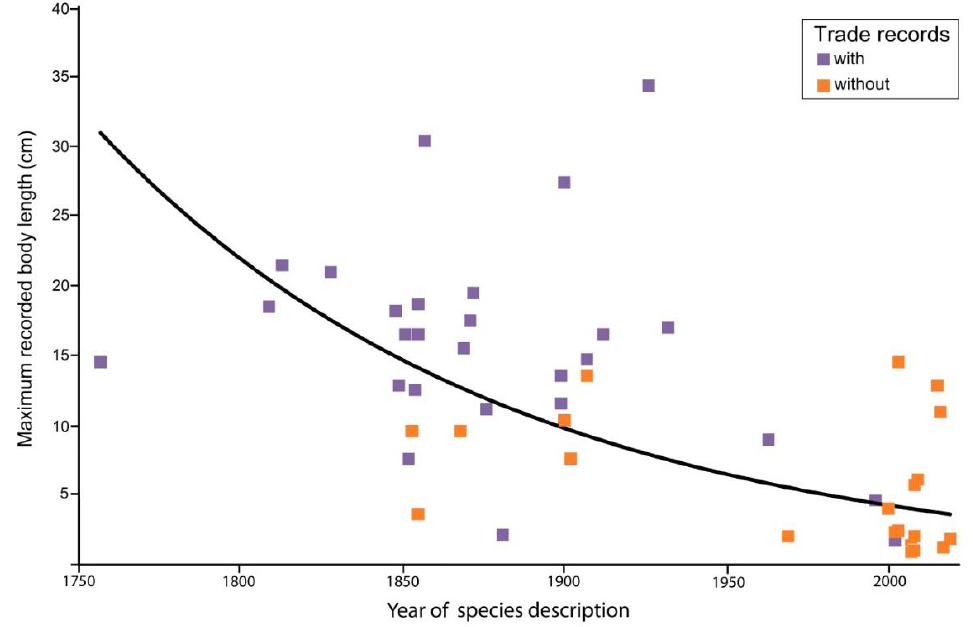
Figure 2. Maximum length of newly described Hippocampus species (1758 – 2020, n = 48), with and without trade records [69], based on data in Table 1, showing a tendency for additional new species to become exponentially smaller in size, approaching the function y = 60.17 × 10 6 × e − 0.01x (Pearson correlation coefficient, ln-transformed (R = − 0.675, p < 0.00001).